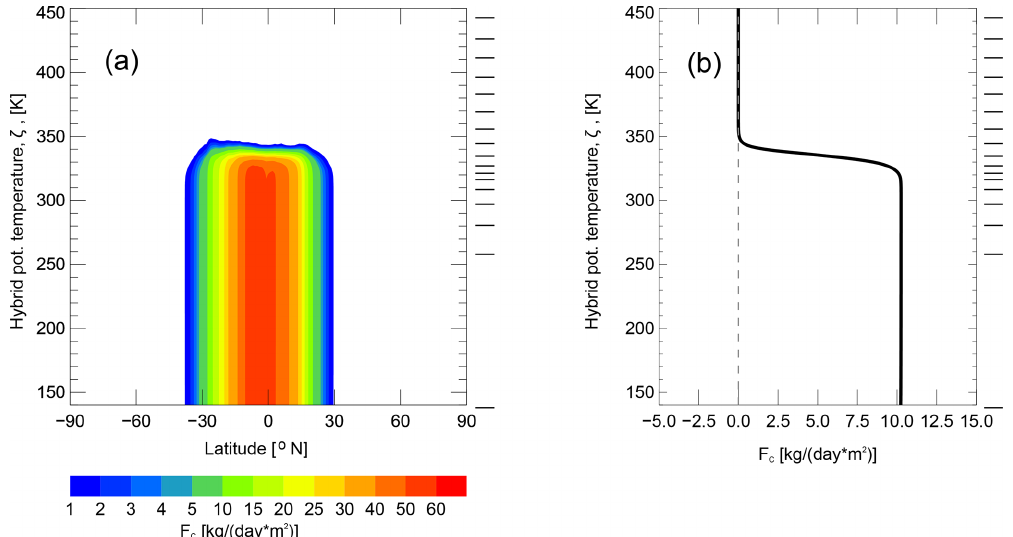
Figure C1. Annually averaged and zonally resolved updrafts due to parametrized convection ( σ r = 0 . 3) (a) and their global mean (b) . On the right side of panel (a) the boundaries of CLaMS layers, (cid:49)ζ i , i = 1 ...N , are